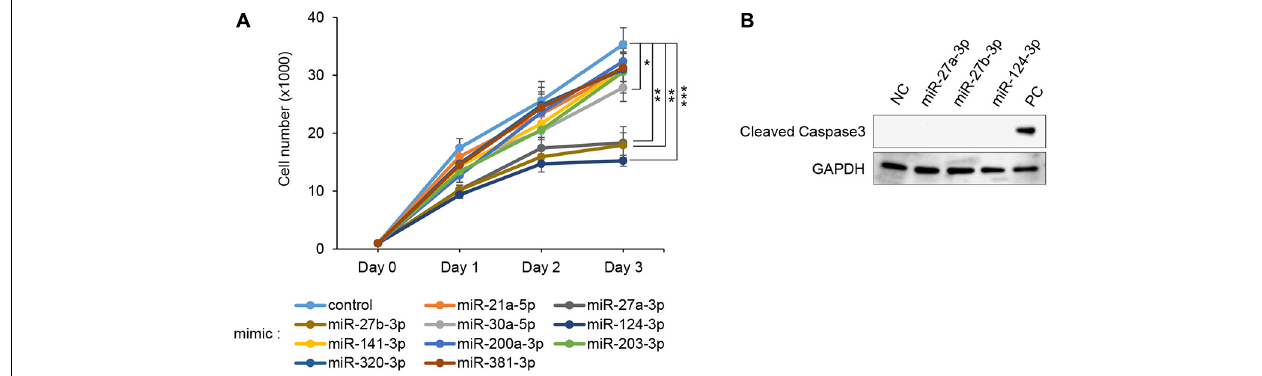
FIGURE 1 | Effect of overexpression of the predicted miRs on cell proliferation in MEPM cells. (A) Cell proliferation assays using MEPM cells from E13.5 palatal shelves treated with the indicated miR mimic; control, miR-21a-5p, miR-27a-3p, miR-27b-3p, miR-30a-5p, miR-124-3p, miR-141-3p, miR-200a-3p, miR-203-3p, miR-320, and miR-381-3p mimic. Two-way ANOVA with Dunnett’s test ( n = 6). * p < 0.05, ** p < 0.01, *** p < 0.001. Each treatment group was compared with the control. (B) Immunoblotting analysis for cleaved caspase 3 in MEPM cells treated with control, miR-27a-3p, miR-27b-3p, or miR-124-3p mimic for 48 h. Intestine was used as a positive control (PC). GAPDH was used as an internal control. Representative images from two independent experiments are shown.